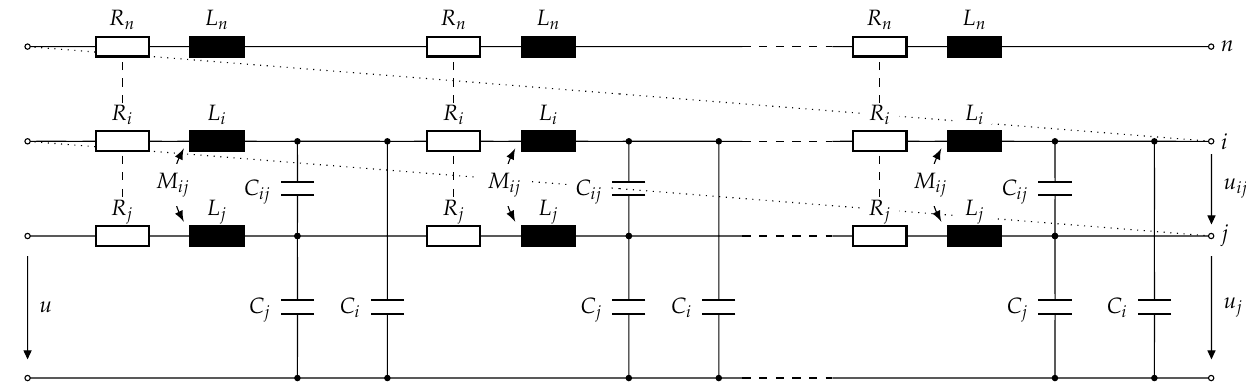
Figure 7. Distributed multi-turn model after subdividing each turn of the multi-turn model in Figure 6, same as in the multi-turn model, the circuit elements are frequency-dependent and all turns including the n th-turn share mutual inductive and capacitive coupling (not drawn)